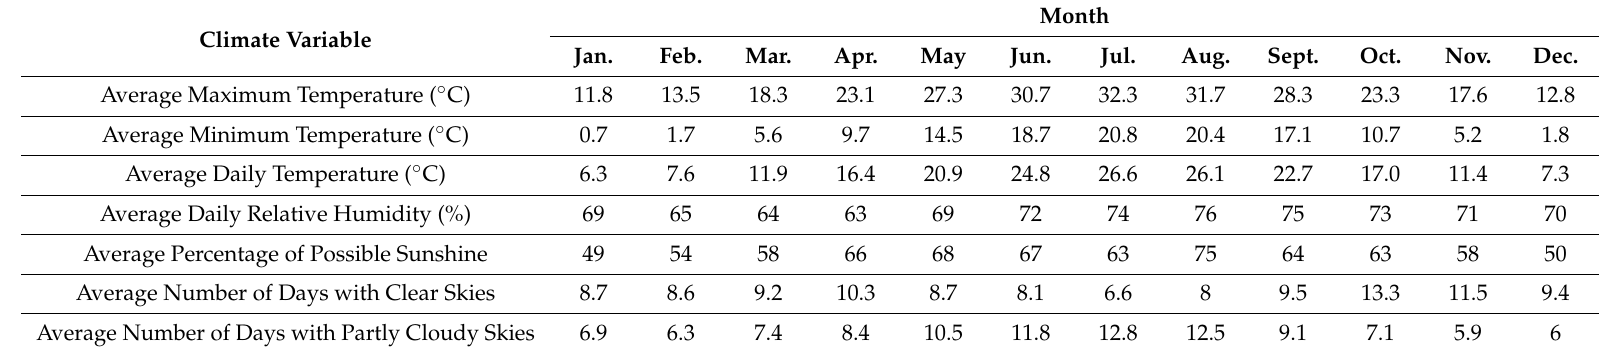
Table 1. Monthly values of climate variables of the research location. Climate